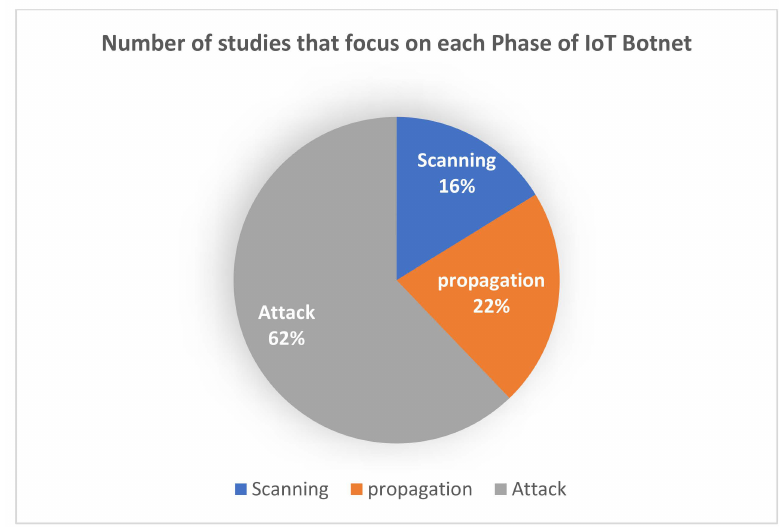
Figure 7. Percentages of studies focusing on the different phases of IoT botnet